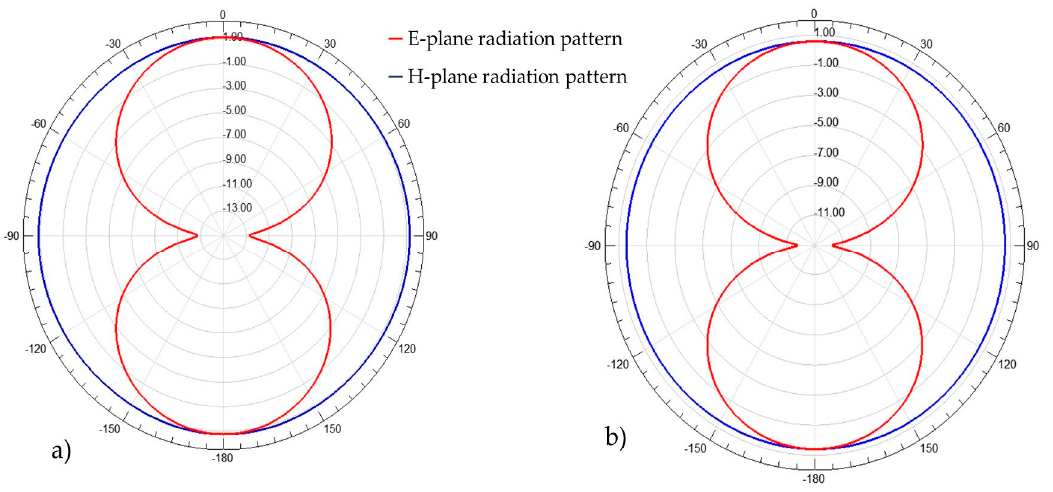
Figure 7. Radiation pattern on the E-plane and H-plane at 868 MHz. ( a ) The antenna first 3D dipole antenna in Section 2.1; ( b ) The modified 3D dipole antenna (A2).